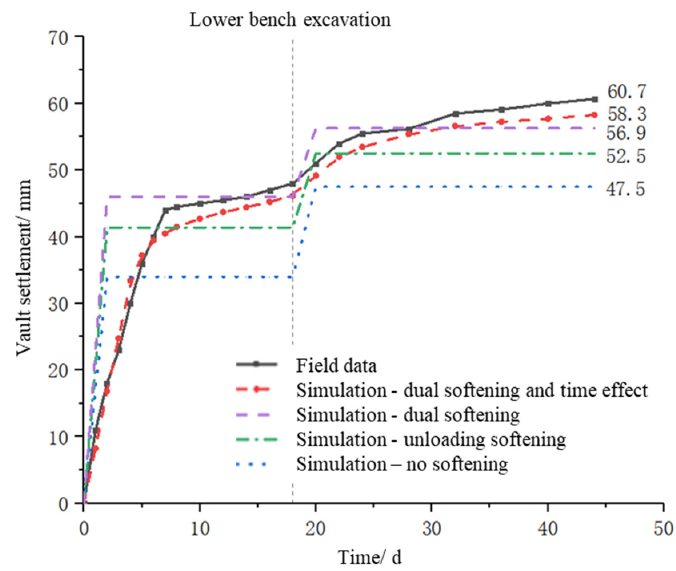
Figure 20. Curves of field monitoring and simulations of the vault settlement at section K14 + 885.